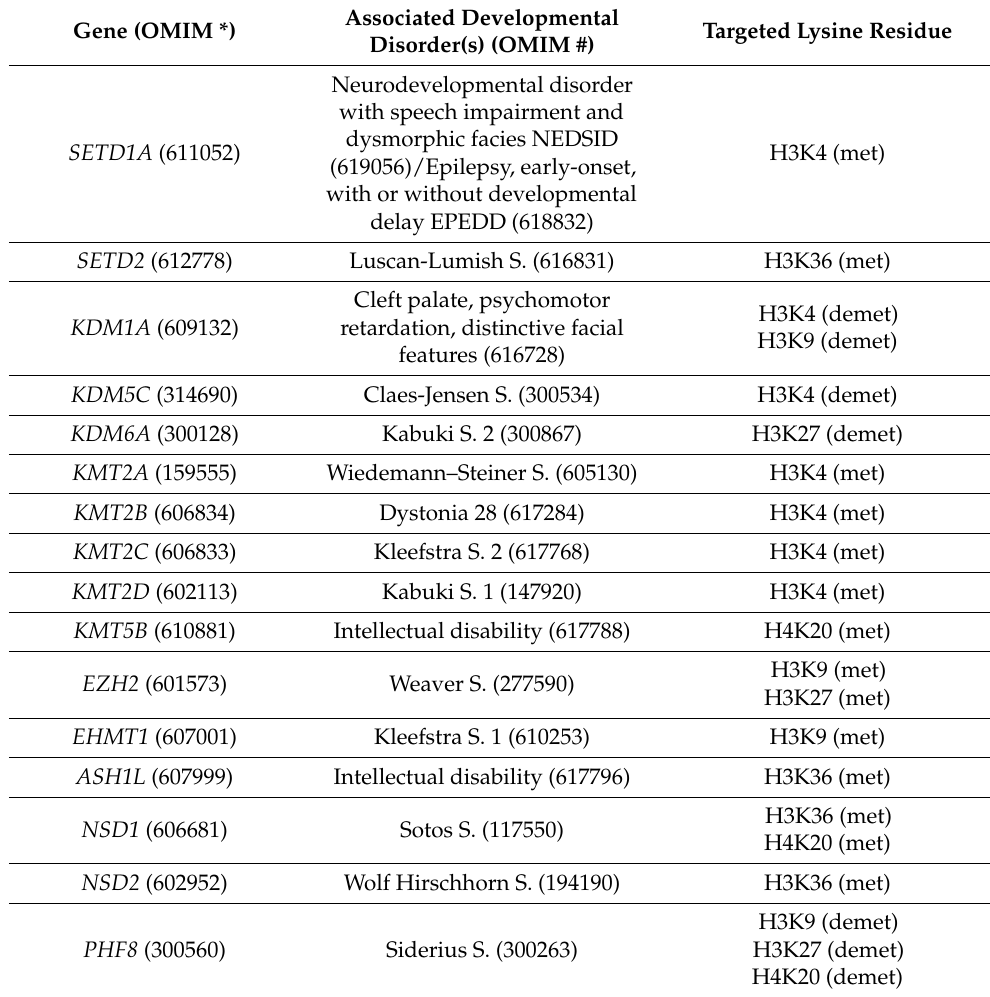
Table 1. Details of genes and syndromes represented in Figure